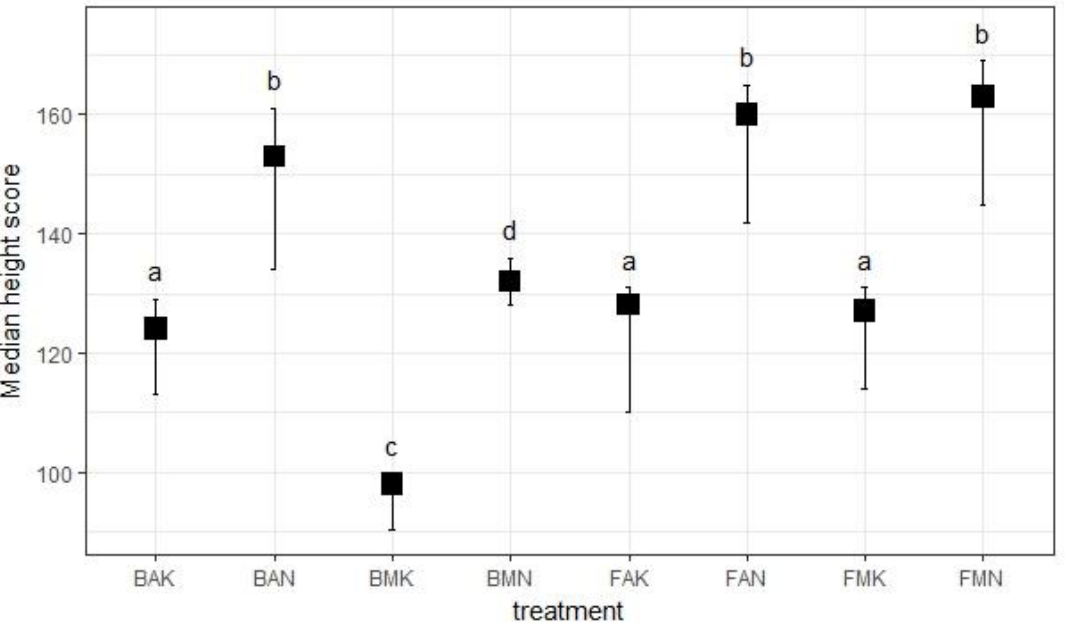
Figure 9. Results of Wilcoxon rank sum test on tree height for nyamplung and kemiri sunan (BAK—agroforestry kemiri sunan plot B; BAN—agroforestry nyamplung plot B; BMK—monoculture kemiri sunan plot B; BMN—monoculture nyamplung plot B; FAK—agroforestry kemiri sunan plot A; FAN—agroforestry nyamplung plot A; and, FMK—monoculture kemiri sunan plot A; FMN—monoculture nyamplung plot A). The letters a, b, c, and d on the figure show different performance levels of height.